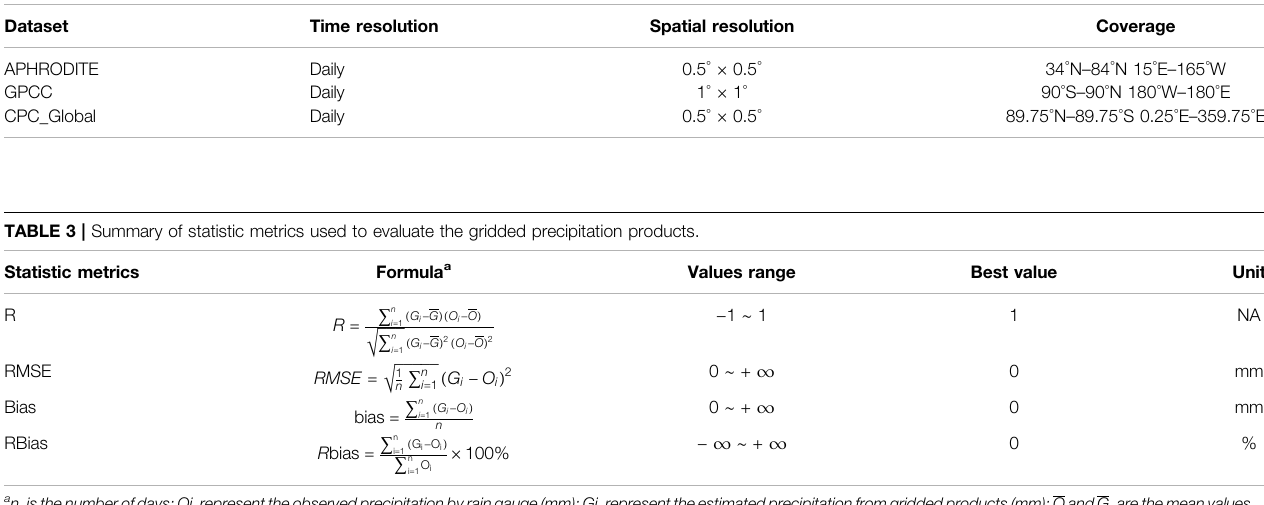
Frontiers in Earth Science |